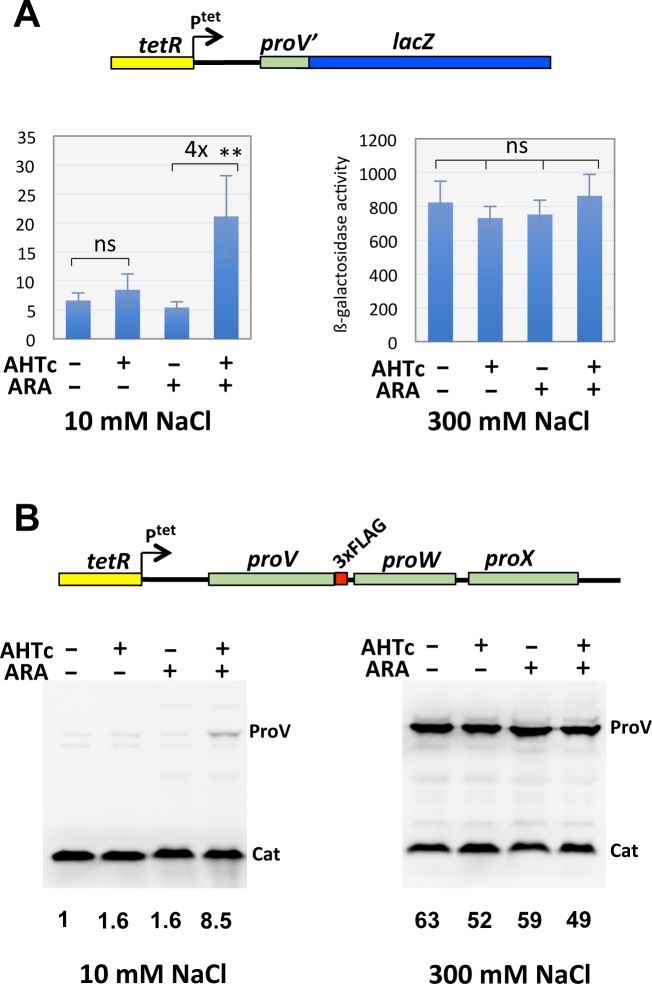
Partial relief of proU repression by invading transcription.The tetR-Ptet cassette was inserted 352 bp upstream from the beginning of the proV orf and the resulting construct moved into strains carrying either al transcriptional lacZ fusion placed 289 bp downstream from the beginning of the proV orf (A) or a C-terminal 3xFLAG fusion to proV (B). The effects of transcription from Ptet (± AHTc) are analyzed in the presence or absence of NusG (- ARA and + ARA, respectively) on early stationary cultures grown in LB medium supplemented with either 10 mM NaCl or 300 mM NaCl (high osmolarity). (A) Quantification of proV-lacZ expression. Cultures were processed for the determination of ß-galactosidase activity as described in Materials and methods. The assays were repeated twice, each time using two independent cultures. Statistical significance was calculated by the Student’s T test (two-tailed, unpaired; **, P < 0.01). (B) Western blot detection and quantification of ProV-3xFLAG. Values below the blots represent the fold change in band intensity relative to the untreated low osmolarity sample (leftmost lane of left blot), normalized to the Cat band for each lane. Band intensity was quantified with ImageJ.